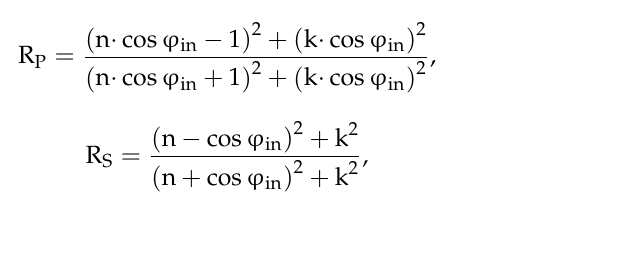
Table 3. Overview of the camera’s FOV in dependence of the analyzed sets.